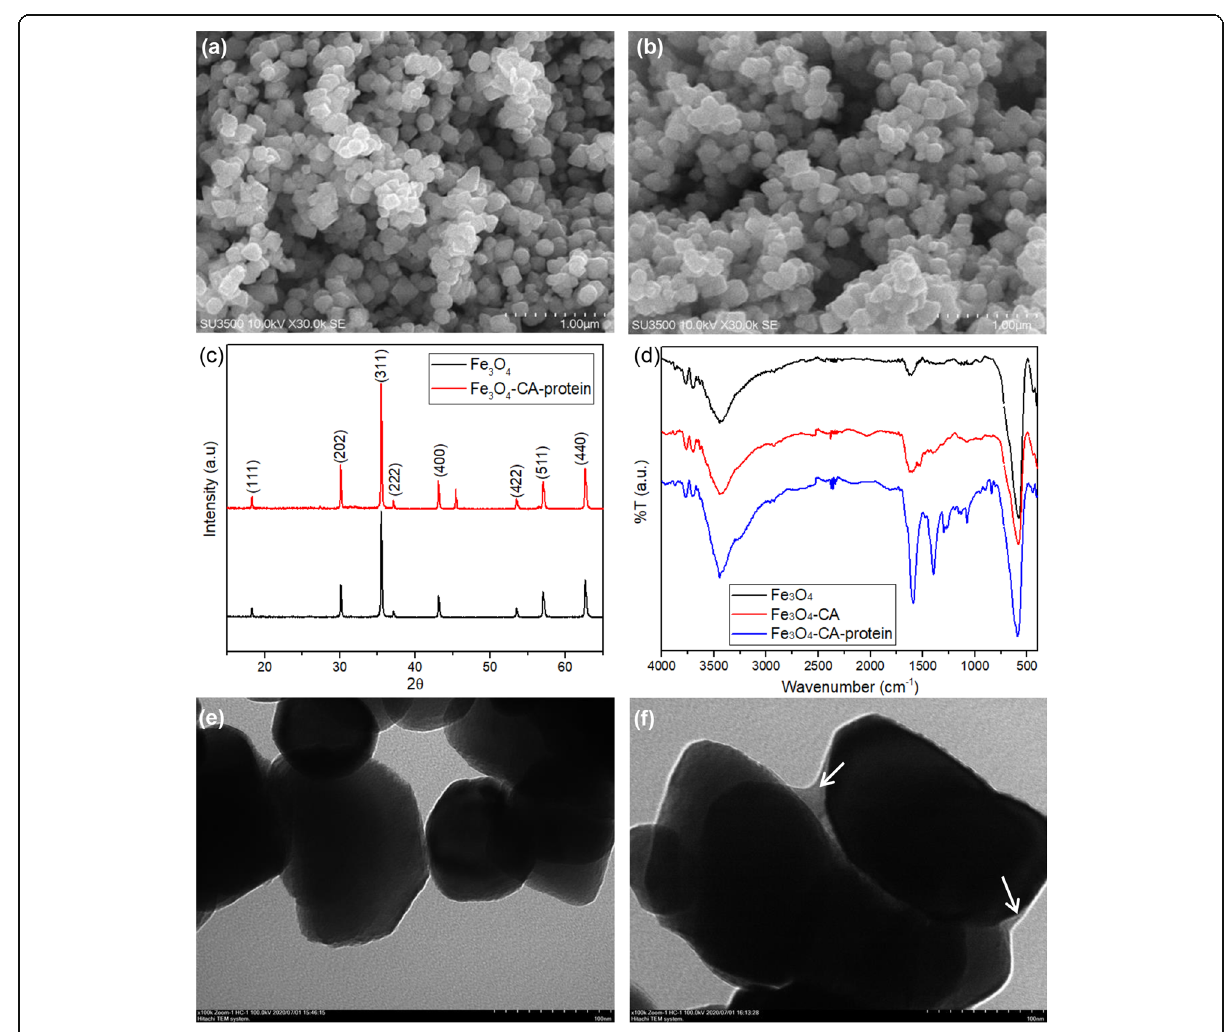
Fig. 2 Morphology of Fe 3 O 4 ( a ) and Fe 3 O 4 -CA-protein ( b ) at magnification of 30,000×, XRD spectra ( c ), FTIR spectra ( d ), and TEM images of Fe 3 O 4 ( e ) and Fe 3 O 4 -CA-protein ( f